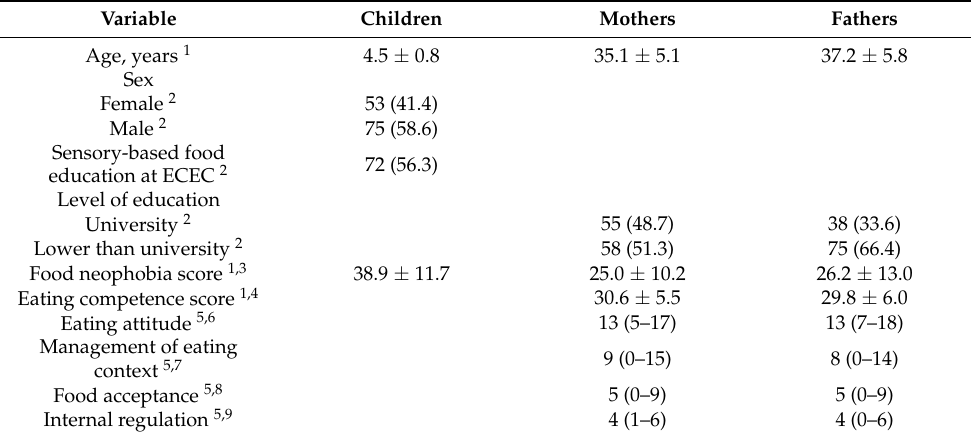
Table 1. Background information of the 3–5-year-old children ( n = 128) and their mothers ( n = 113) and fathers ( n =